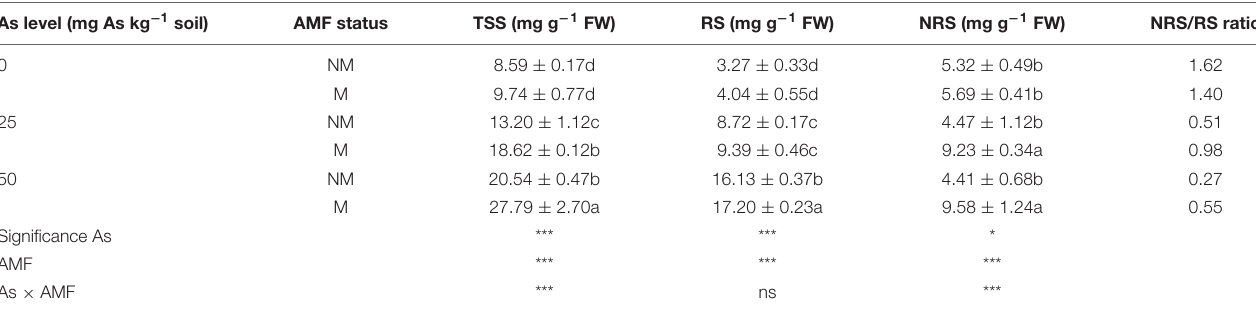
TABLE 4 | Concentrations of TSS, RS, NRS, and NRS/RS ratio in leaves of Triticum aestivum in response to Rhizophagus intraradices inoculation (M, mycorrhizal; NM, non-mycorrhizal) and As addition to the soil. As level (mg As kg − 1